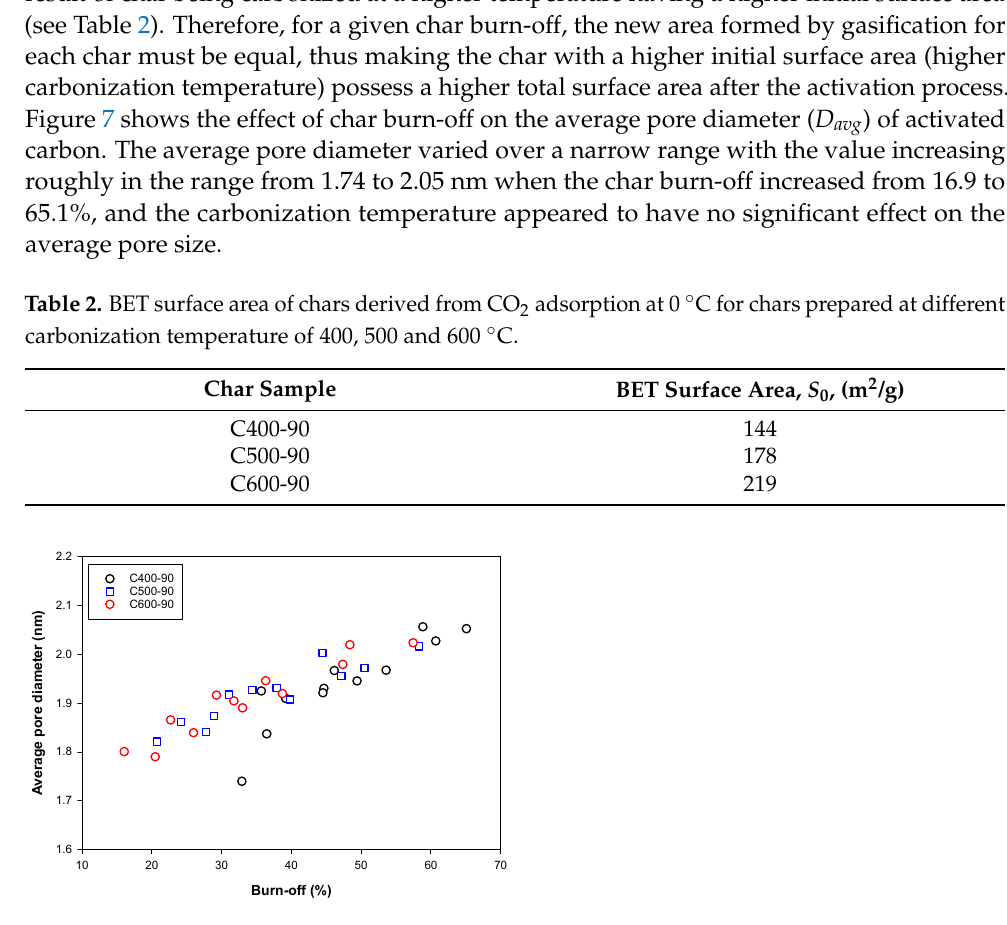
Figure 7. Effects of char burn - off on the average pore diameter of the prepared activated carbons .